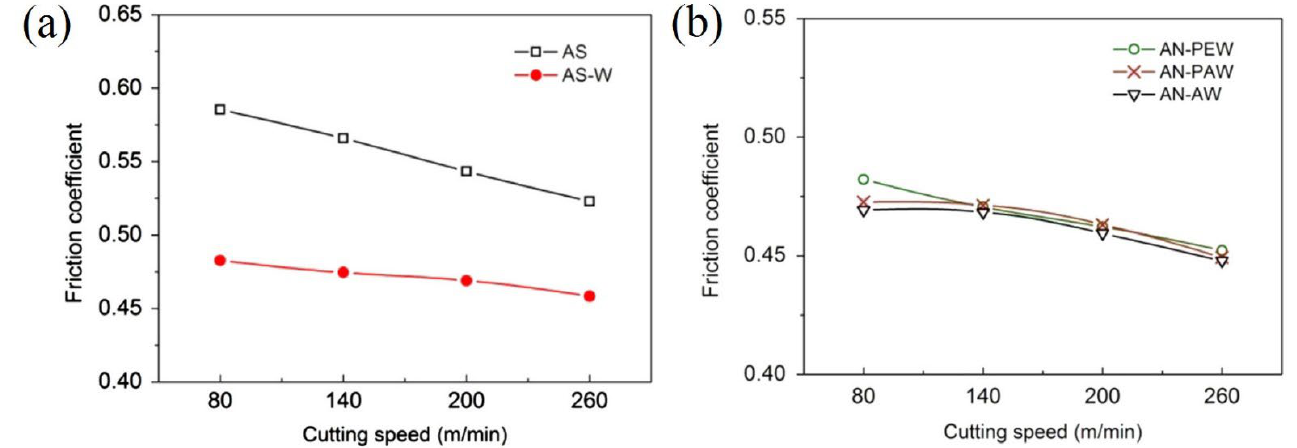
Figure 8. Friction coefficient at the tool–chip interface at different cutting speeds of: ( a ) conventional tools with (AS-W) and without (AS) WS 2 /Zr composite soft-coatings; ( b ) three kinds of nano-textured tools deposited with WS 2 /Zr composite soft-coatings [40].